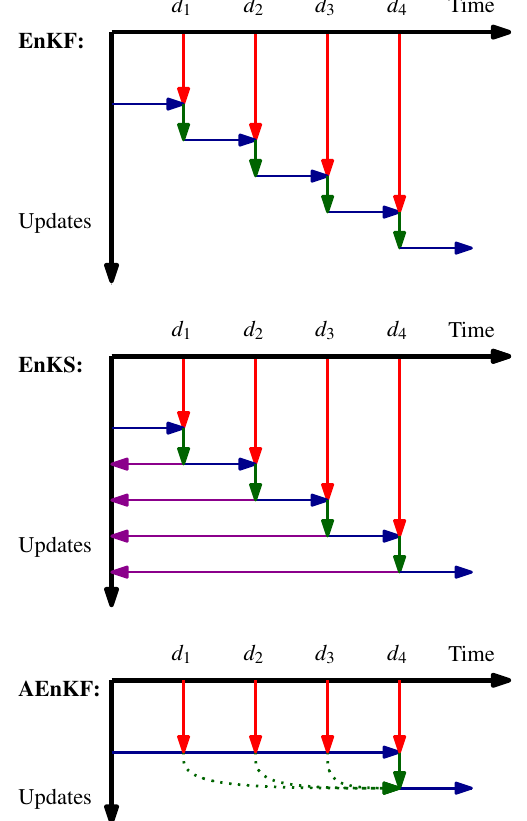
Figure 1. Illustration of the model updating procedure for the ensemble Kalman filter (EnKF), the ensemble Kalman smoother (EnKS), and the asynchronous ensemble Kalman filter (AEnKF). The horizontal axis stands for time, observations ( d 1 , d 2 , d 3 , d 4 ) are given at regular intervals. The blue arrows represent forward model integration, the red arrows denote introduction of observations and green arrows indicate model update. The magenta arrows represent the model updates for the EnKS and therefore go backward in time, as they are computed following the EnKF update every time ob- servations become available. The green dotted arrows denote past observations being assimilated using the AEnKF. The schemes for the EnKF and the EnKS are after Evensen